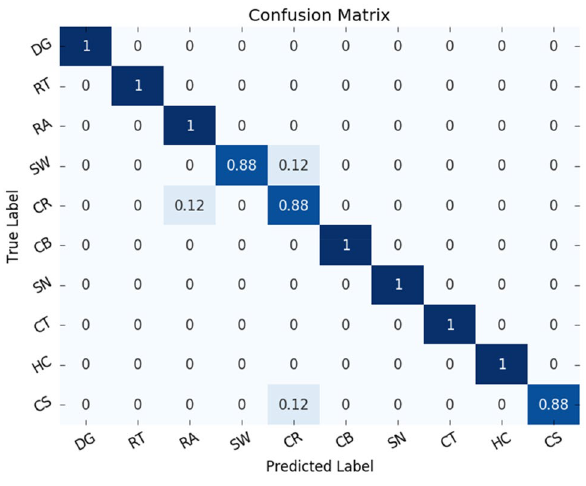
Figure 13. Confusion Matrix of RACNN on ESC-10 dataset.